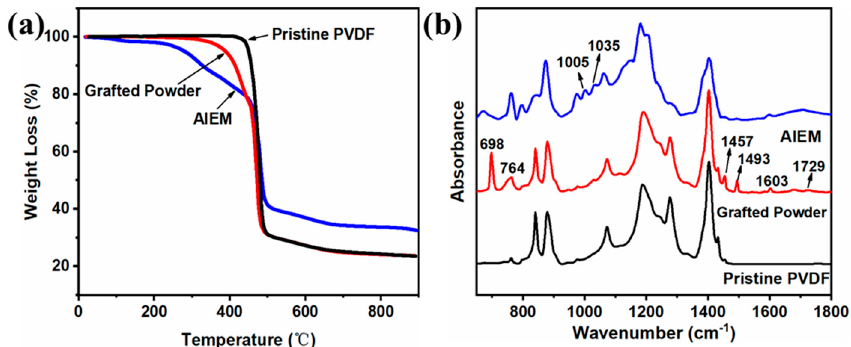
Figure 5. ( a ) TGA curves and ( b ) FTIR spectra of pristine PVDF, grafted powder, and AIEM (GY = 28.4%).